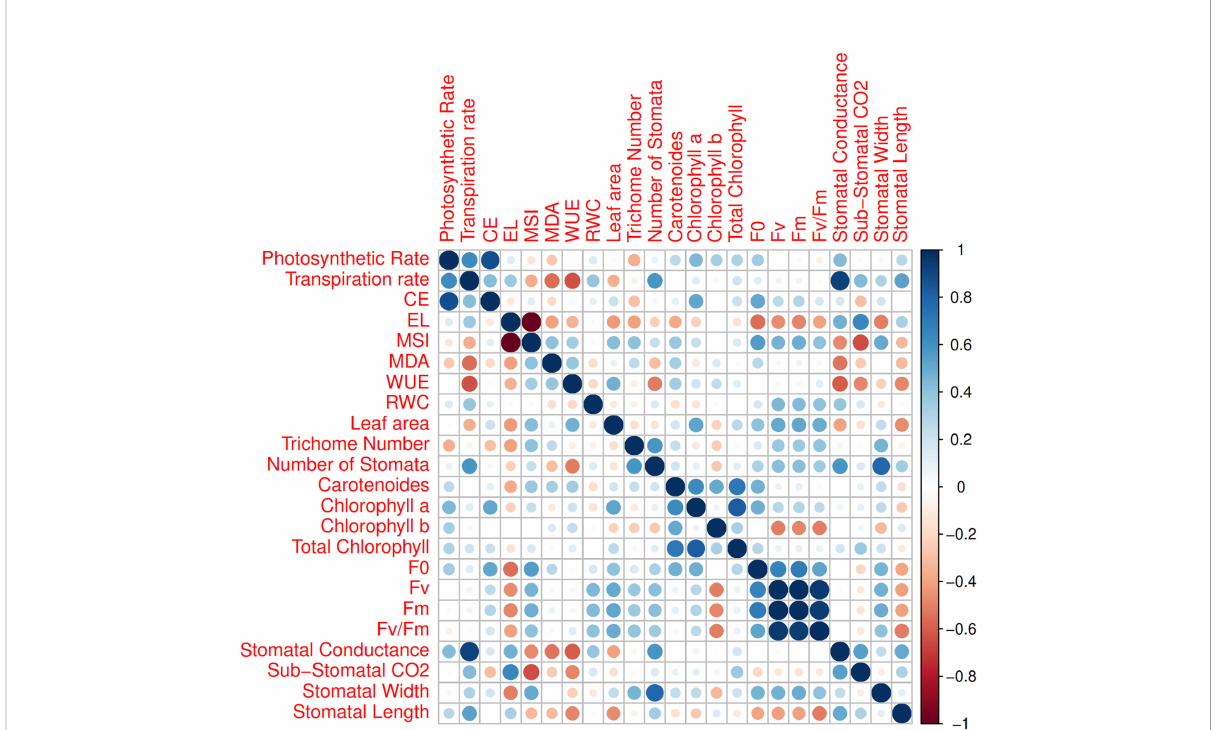
FIGURE 7 Corrplot between various measured parameters of 16 Iranian licorice accessions. CE (Carboxylation Ef fi ciency), EL (Electrolyte Leakage), MSI (Membrane Stability Index), MDA (Malondialdehyde), WUE (Water Use Ef fi ciency), RWC (Relative water content), F0 (Initial fl uorescence intensity), Fv (Variable fl uorescence), and Fm (Maximal fl uorescence intensity).